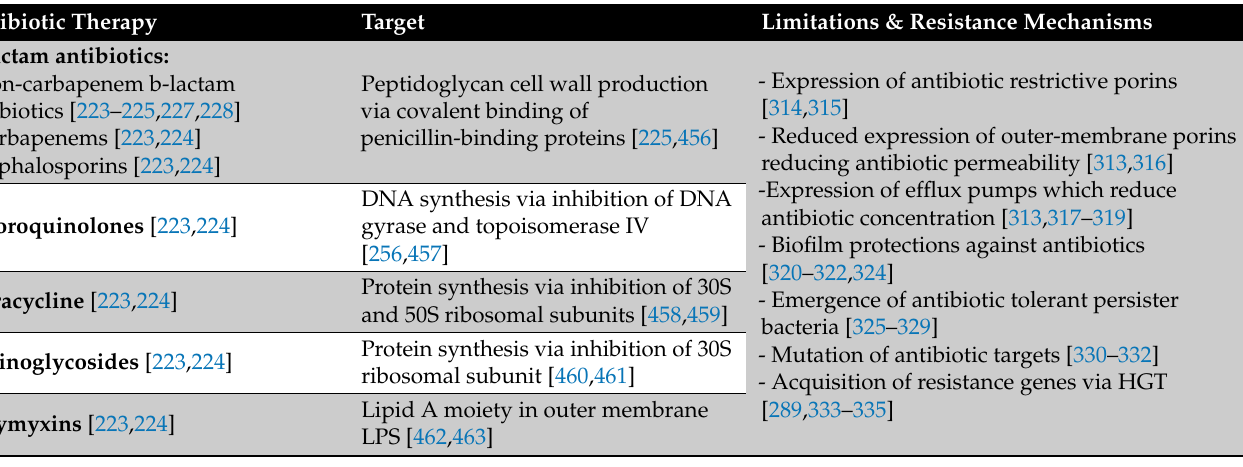
Table 2. Conventional antibiotic treatments for Pseudomonas aeruginosa infections, their limitations, and mechanisms of resistance in P. aeruginosa